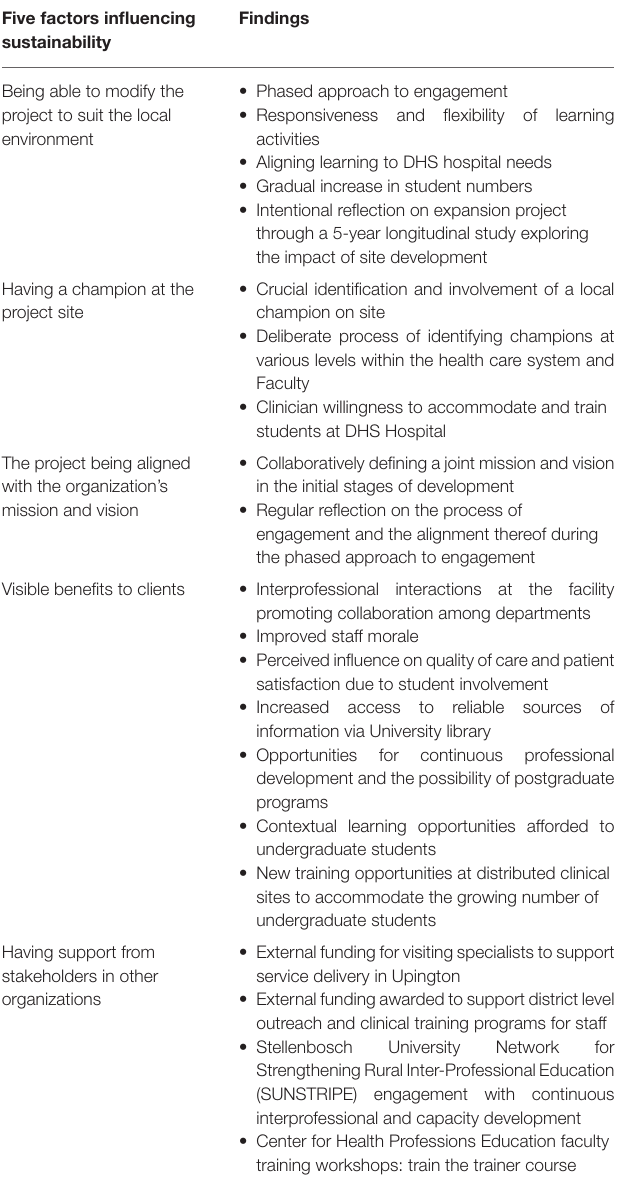
TABLE 3 | A summary of stakeholders’ perspectives on the development of the Upington training site that relate to programme sustainability as described by Scheirer